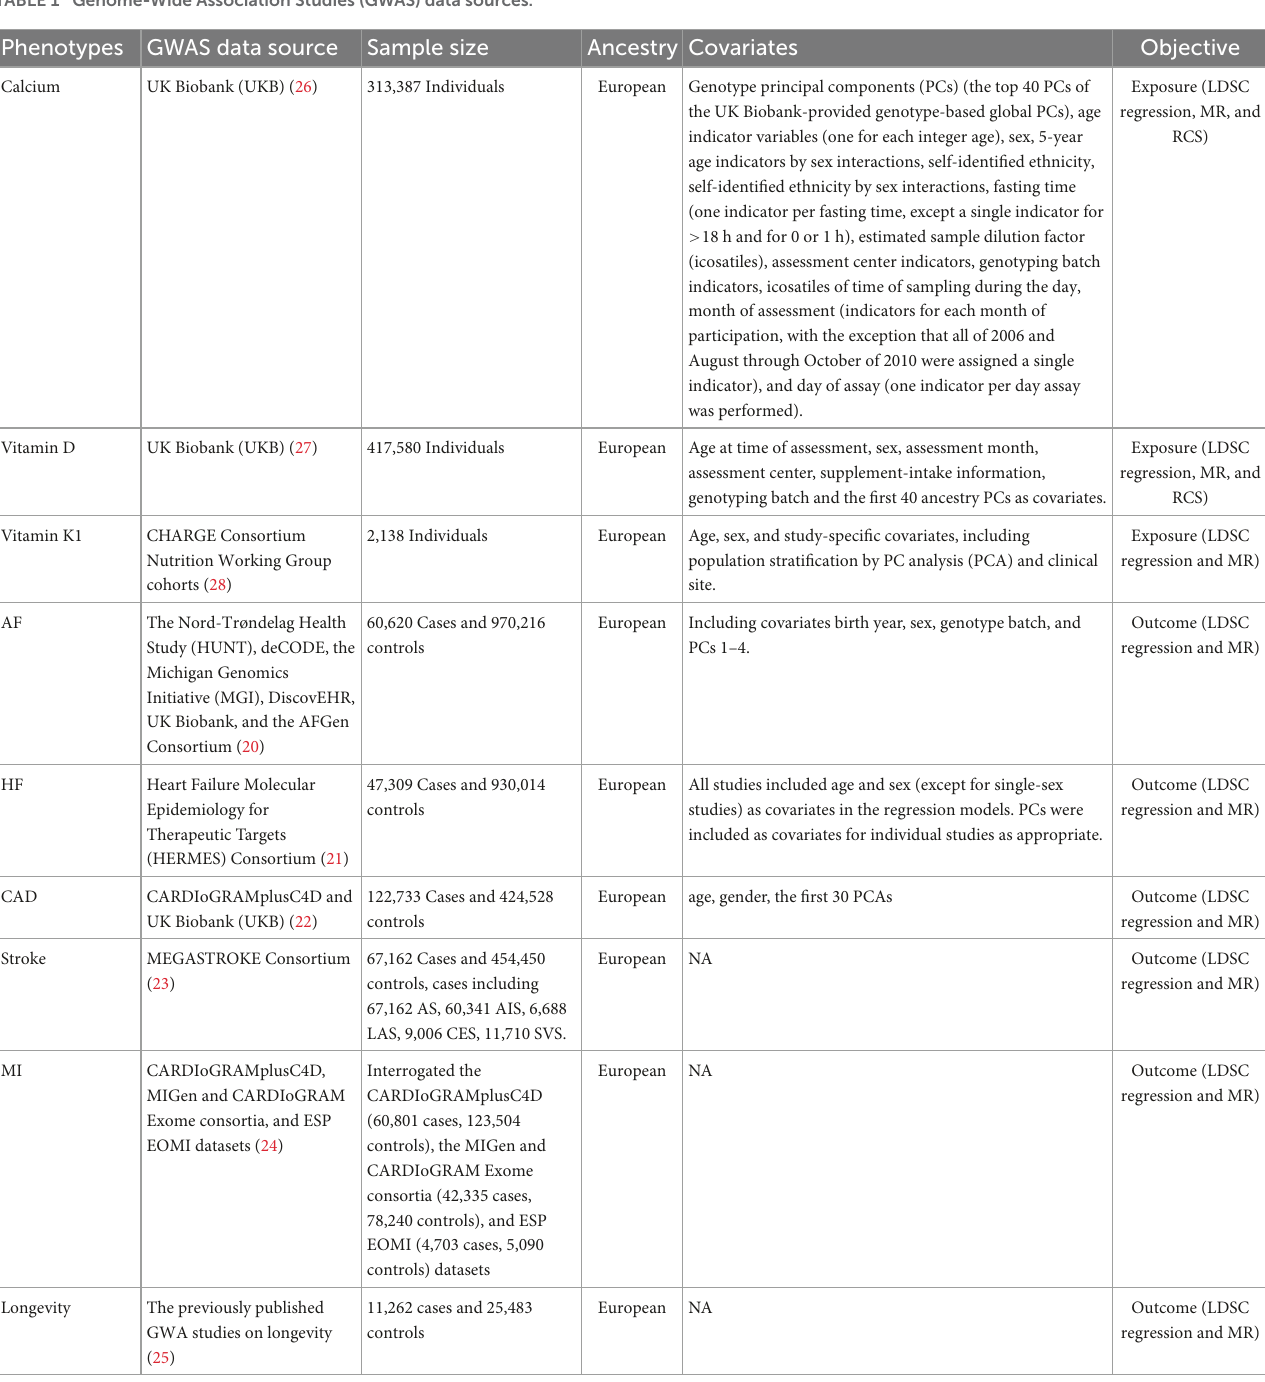
TABLE 1 Genome-Wide Association Studies (GWAS) data